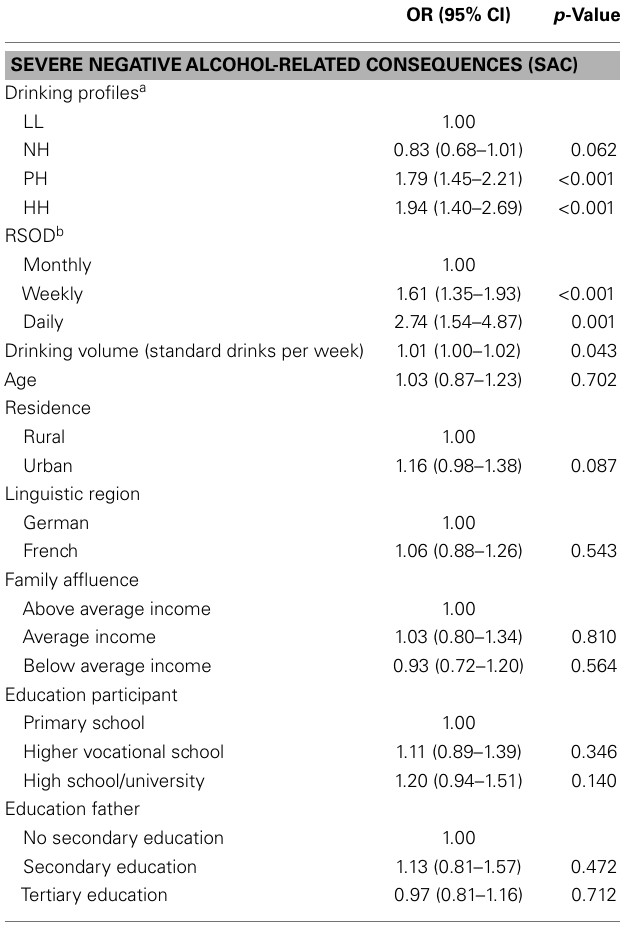
Table 4 | Logistic regression models of drinking profiles